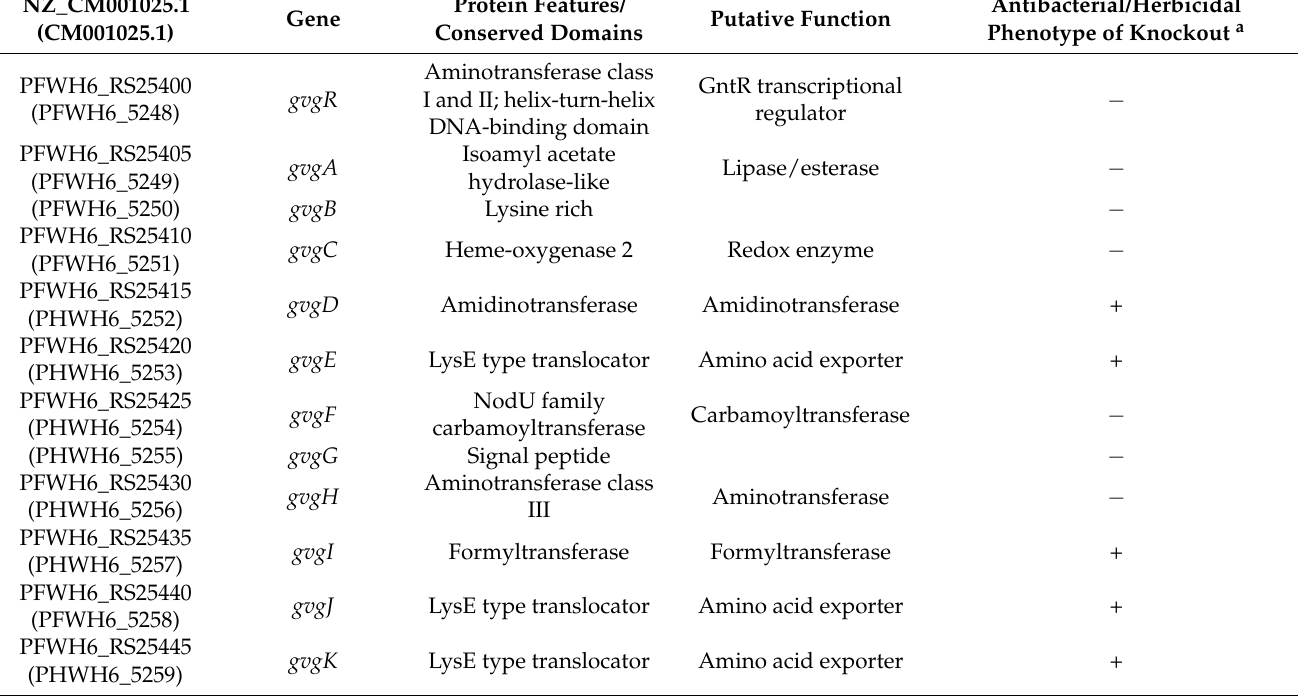
Table 1. gvg operon loci conserved domains, putative function, and mutant phenotype. Antibacterial/Herbicidal Putative Function Conserved Domains Phenotype of Knockout a GntR transcriptional